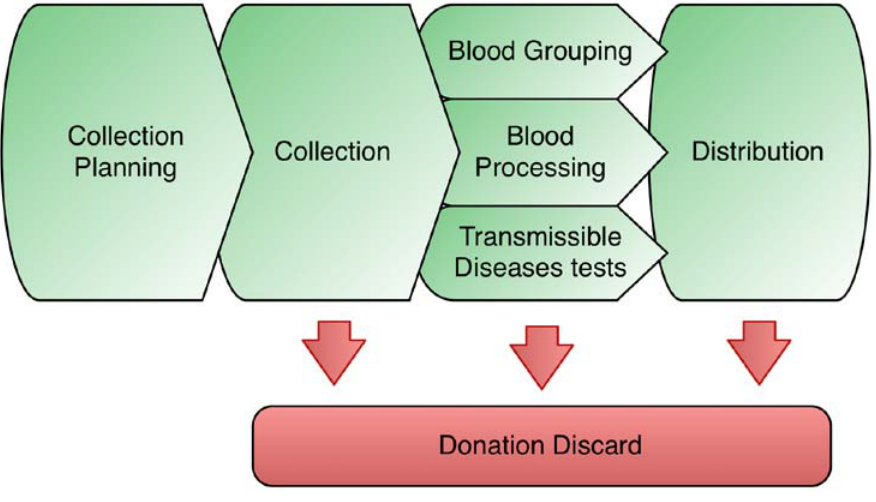
Figure 1: Blood Establishment